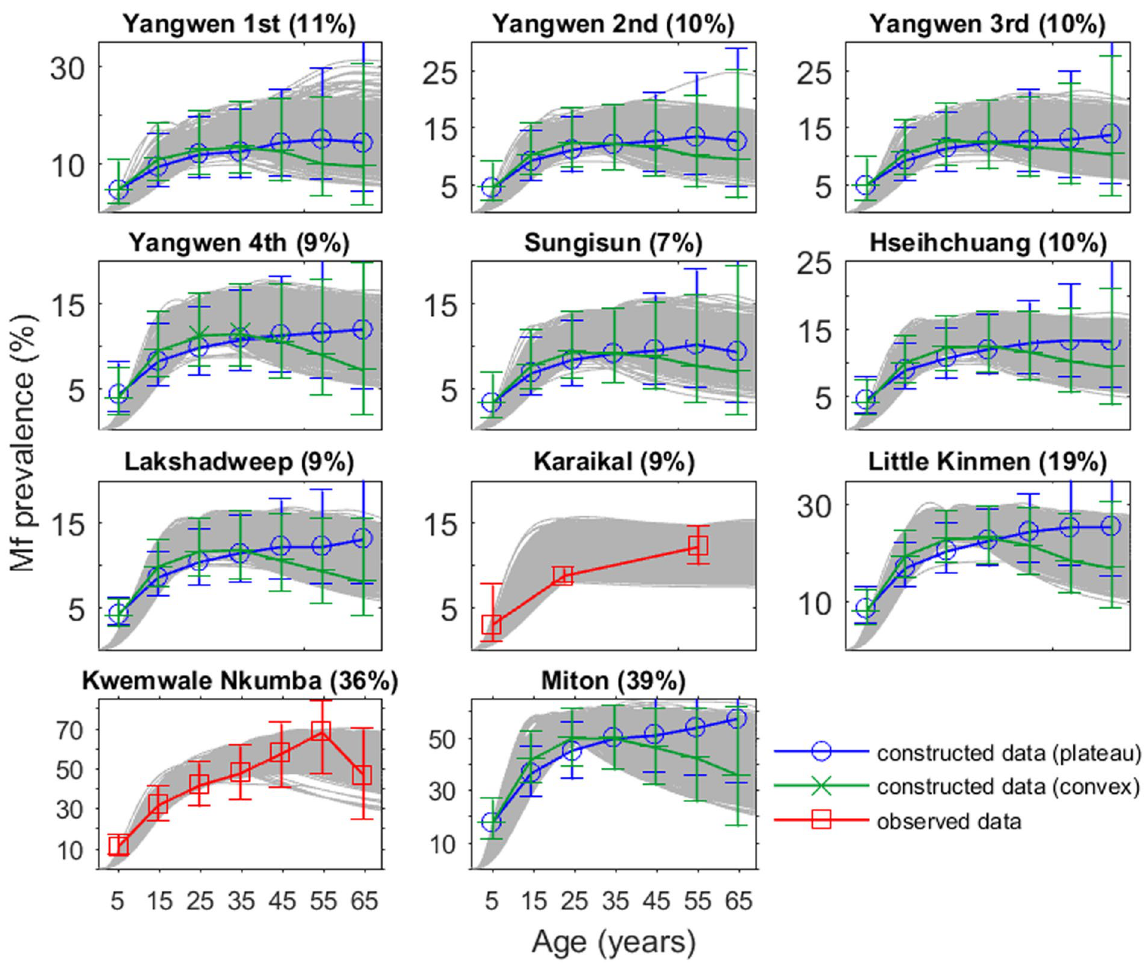
Figure 1. Model fits to baseline prevalence data for the 11 sites used in this study. Model fits generated by the BM fitting procedure are shown as gray age infection curves. The data shown is either observed age-stratified infection prevalence (red squares) or constructed age profiles from observed overall prevalence where age- stratified data was not available (blue circles and green crosses). The overall community level prevalence, corrected for blood volume, is noted in parentheses following the village names in each